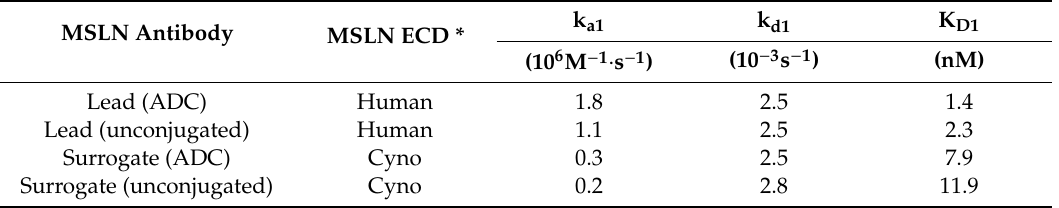
Table 2. Binding kinetics and a ffi nities of mesothelin (MSLN) antibodies to immobilized recombinant human and Cynomolgus monkey MSLN extracellular domain (ECD) proteins determined by